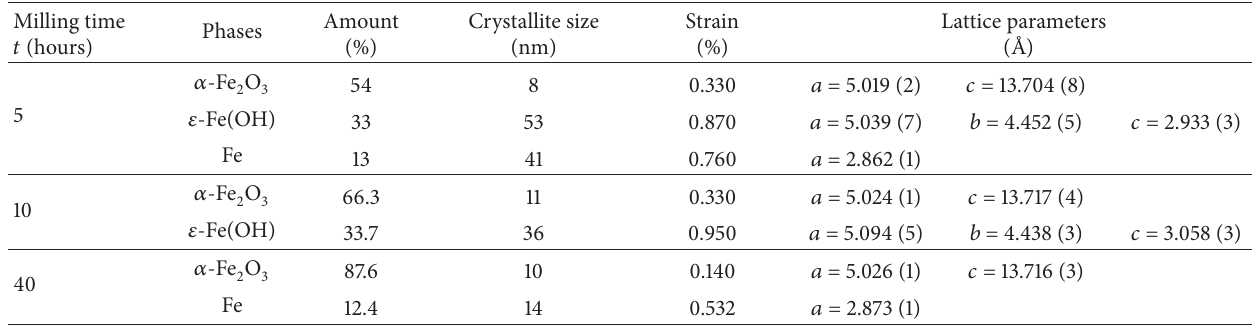
Figure 2: Comparison between standard (Fe 2 O 3 ) powder and goethite powder milled for 40 hours. Table 1: Microstructural parameters as obtained from Rietveld